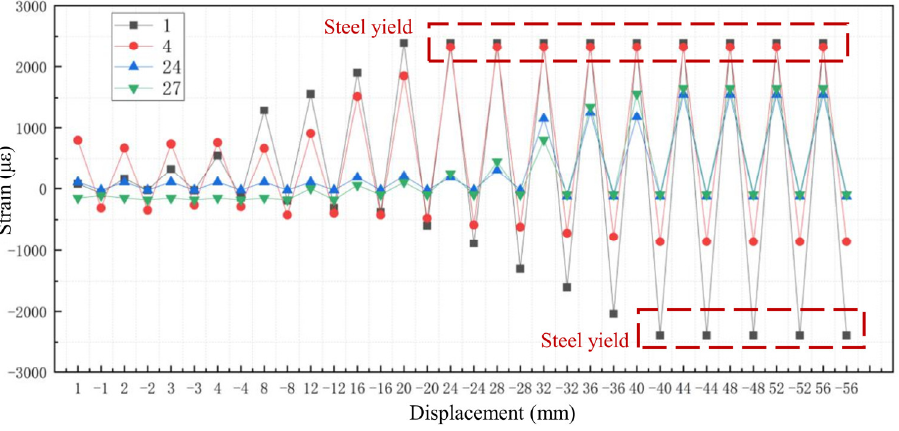
Figure 12. The Strain of longitudinal bar.